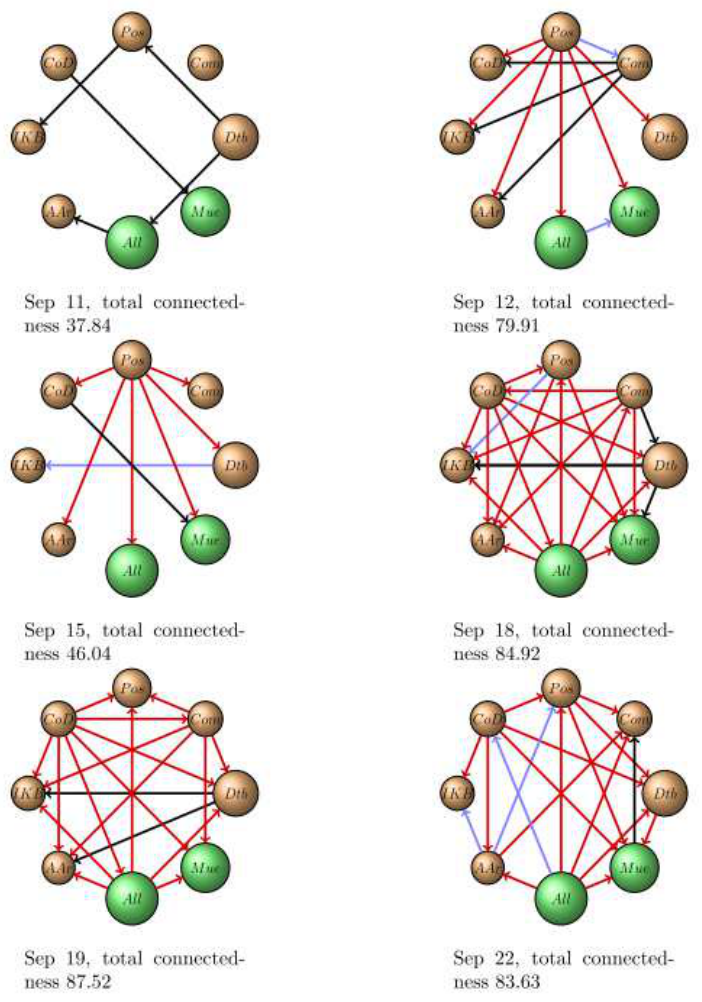
Fig. 7. We plotted all net pairwise directional connectedness more than 5. The black edges describe connectedness between 5 and 8, the blue edges between 8 and 10 and the red ones more than 10. The vertices of Allianz and Münchner Rück are marked green as they are insurance companies. The node size is an indicator for the stock market